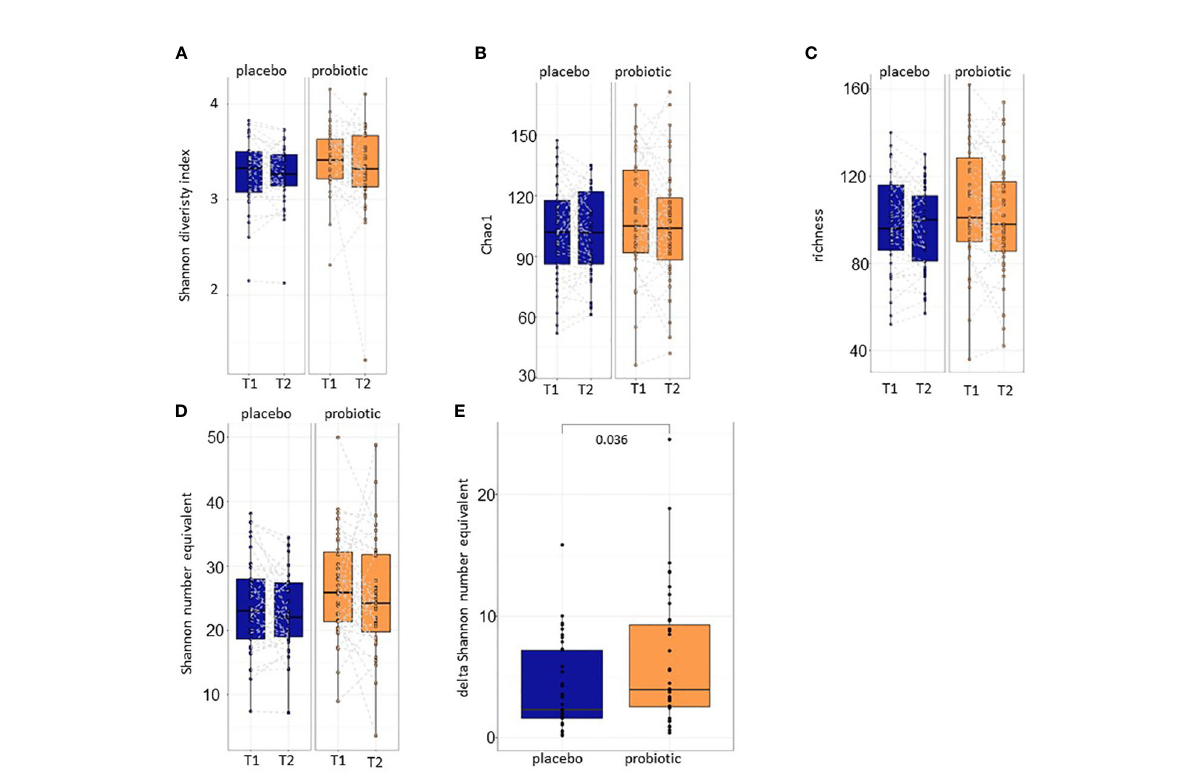
FIGURE 3 Alpha diversity calculations. (A) Shannon diversity index, (B) Chao1 and (C) richness between T1 and T2 of the placebo and the probiotic group. Additionally, the (D) Shannon number equivalent and the (E) delta of the Shannon number equivalent are calculated. T1,timepoint 1, T2, timepoint 2.